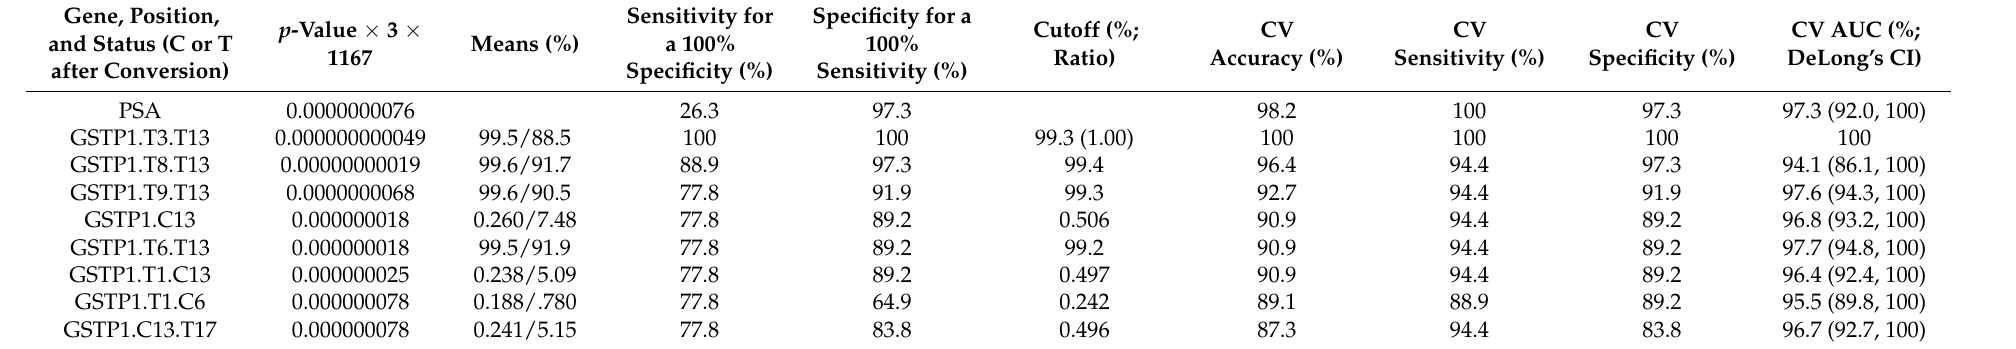
Table 6. Comparison of HDs with a joint group including patients with prostate tumors (BPH +